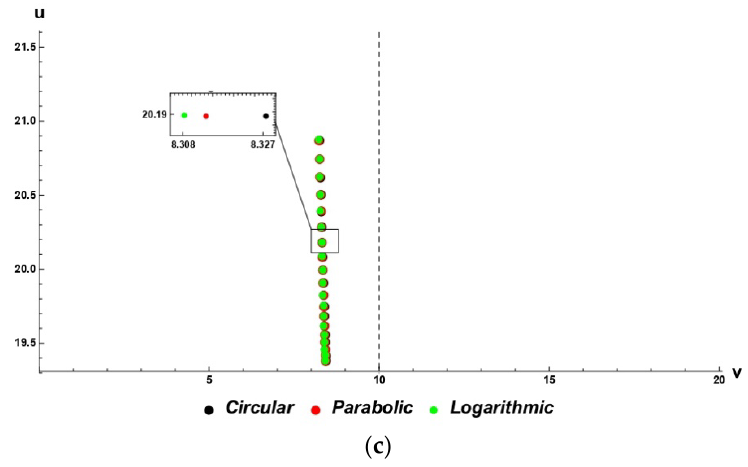
Figure 19. Path of contact of longitude circular, parabolic, and logarithmic crowned helical gear with in-plane misalignment: ( a ) 0.05°(0.87 mrad), ( b ) 0.1°(1.7 mrad), and ( c ) 0.2°(3.5 mrad). The dashed line indicates the center of the tooth surface along the width of the gear.